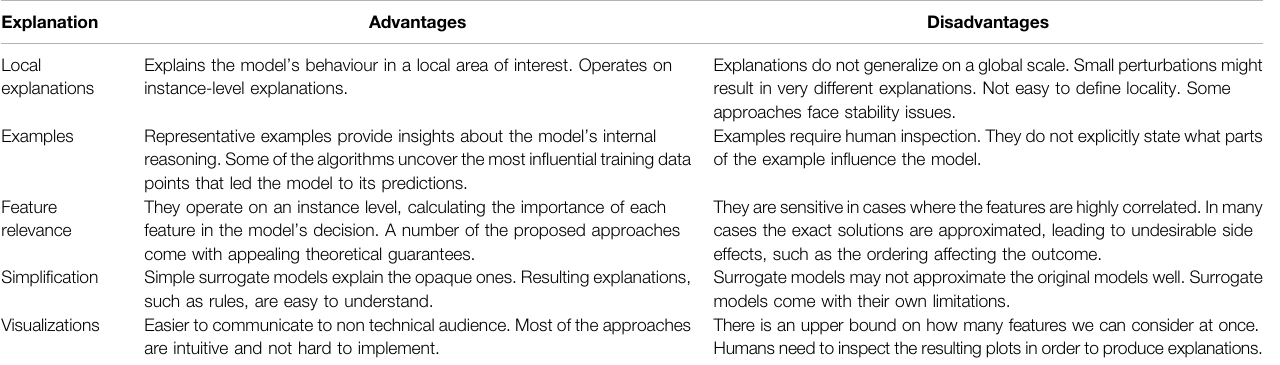
approaches face stability issues.